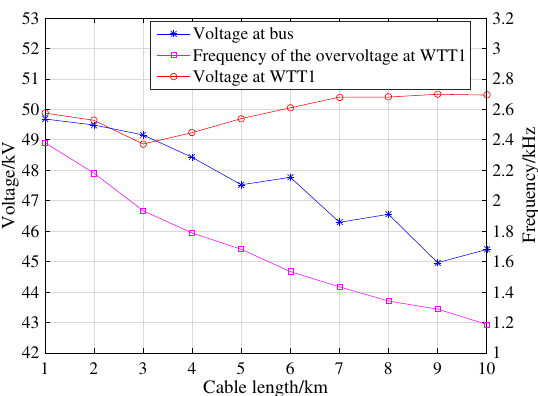
Figure 6. Maximum voltage during energization of radial A and the corresponding oscillation frequencies for cable lengths between the platform and WTT1 from 1 km to 10